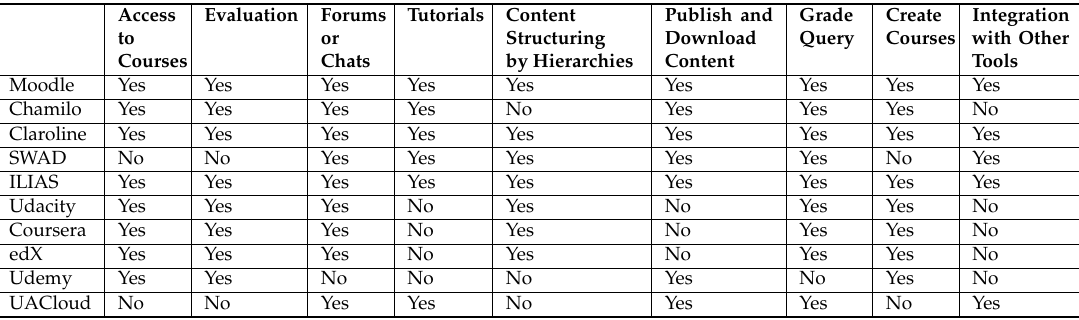
Table 1. Model decision for the pyramidal learning